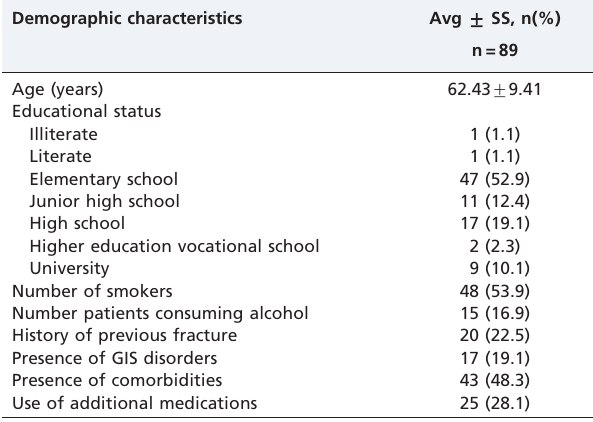
Table 1 - Distribution of the demographic characteristics of the